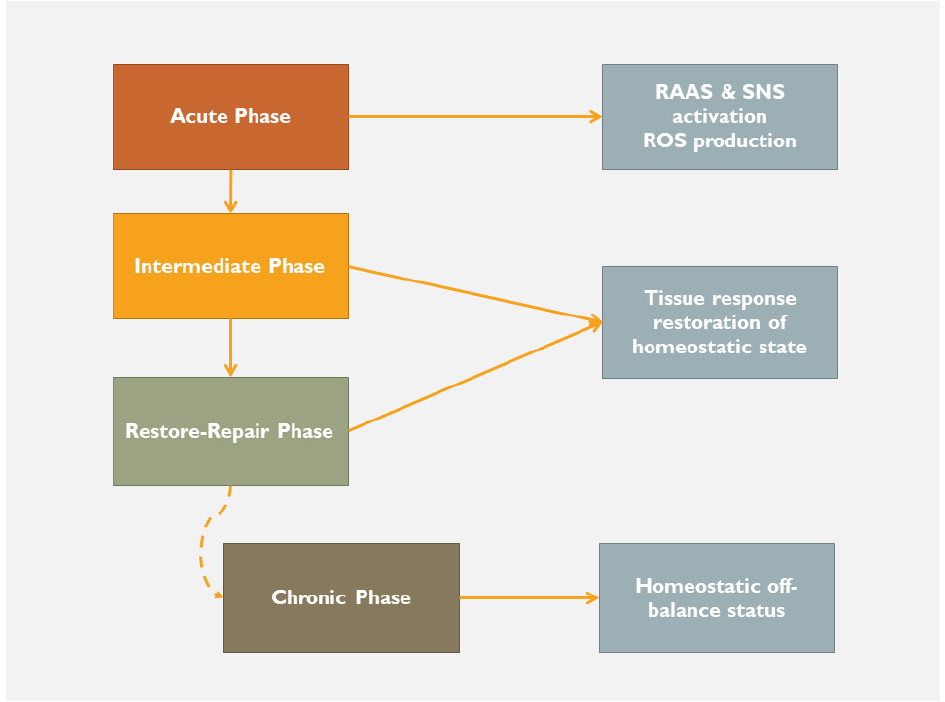
Figure 1. Myocardial inflammatory response to an insult (RAAS—renin-angiotensin-aldosterone system; SNS—sympathetic nervous system; ROS—reactive oxygen species).